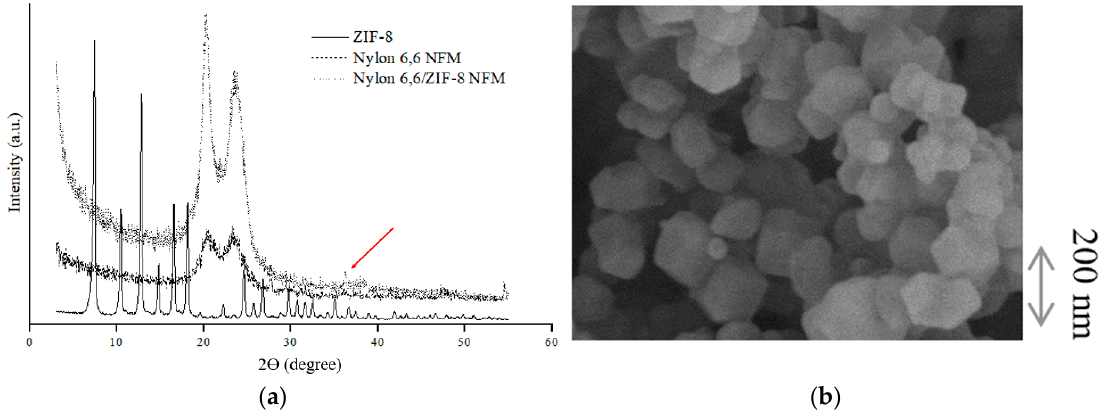
Figure 2. ( a ) XRD patterns for zeolitic imidazolate framework -8 (ZIF-8) nanoparticles, nylon 6,6 nanofiber membrane, and nylon 6,6/ZIF-8 NFM; ( b ) SEM image showing morphology of ZIF-8.